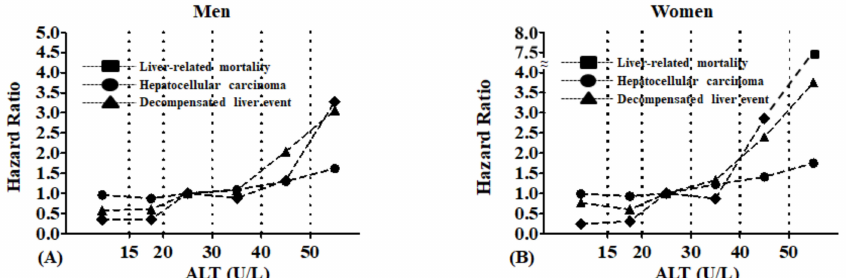
Figure 2. Multivariate hazard ratios relating alanine aminotransferase levels to liver-related mortality, hepatocellular carcinoma, and decompensated liver events according to Cox regression (adjusted for age, body mass index, smoking, exercise, alcohol consumption, fasting blood glucose, and cholesterol levels): ( A ) Men and ( B )